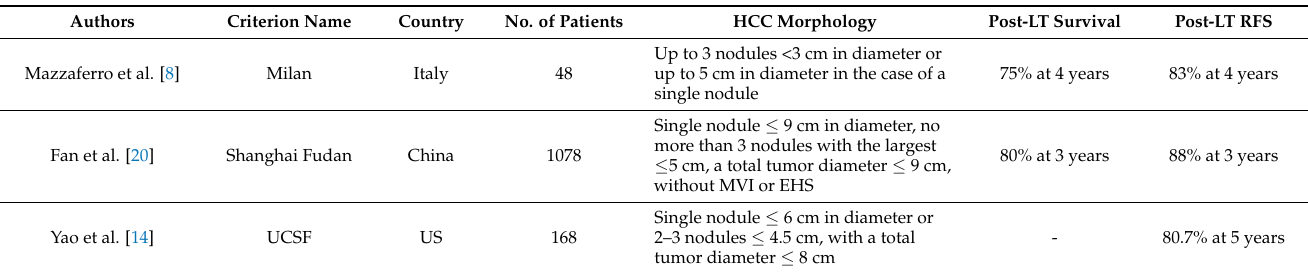
Table 1. The preoperative selection criteria for liver transplantation (LT) in patients with hepatocellular carcinoma (HCC) based on morphological characteristics of the tumor. Only the externally validated selection criteria are reported in the table.